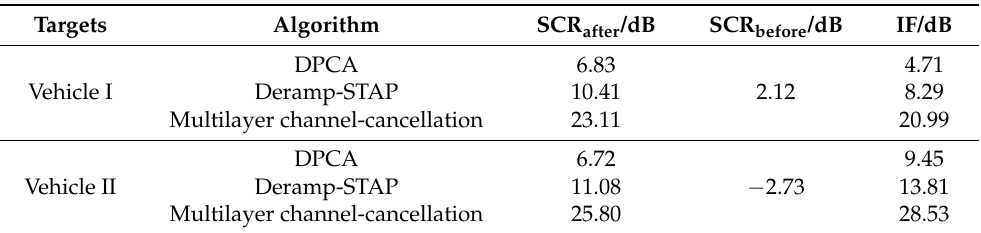
Table 7. SCR and IF of the detected moving targets before and after clutter suppression through the proposed algorithm and the DPCA.